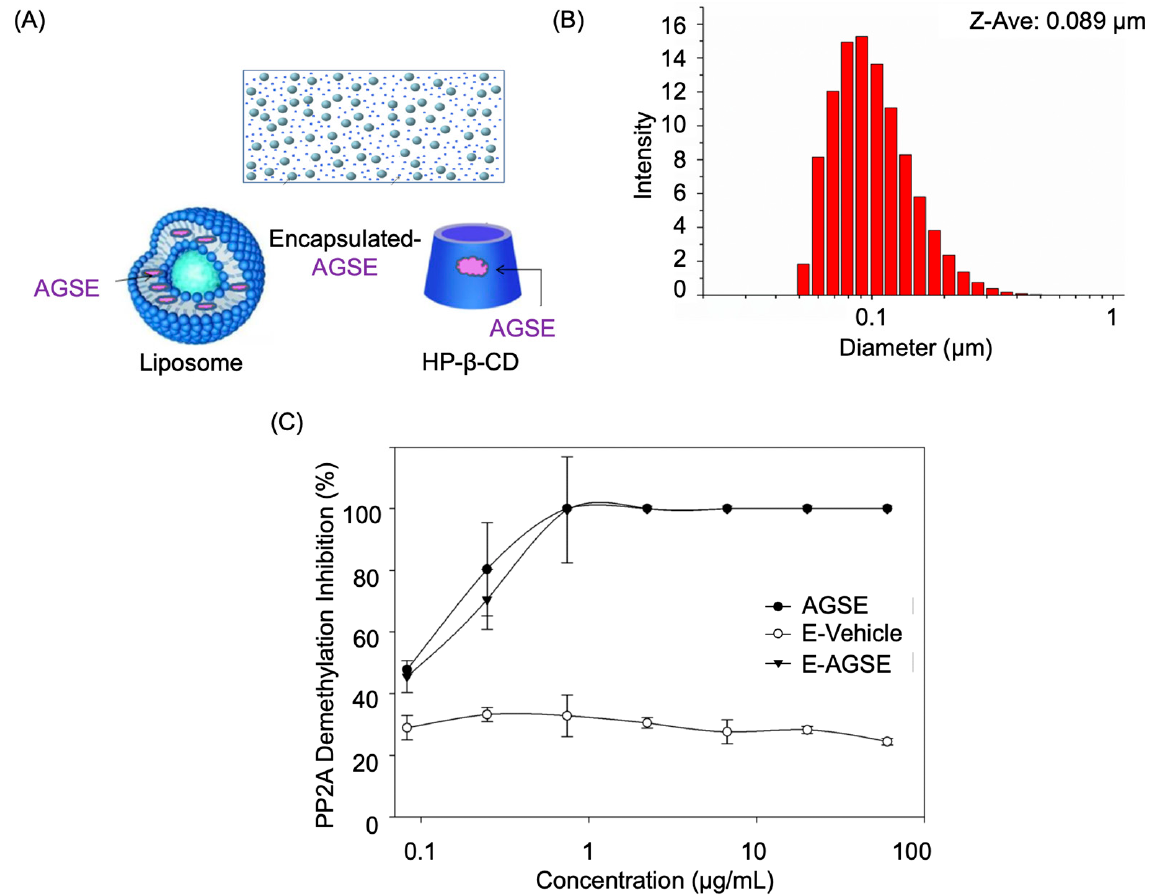
Figure 1. Chemical encapsulation of AGSE retains inhibition of PP2A demethylation activity. ( A ) Chemical encapsulation formulation utilizing liposome and HPCD-based approaches. ( B ) The particle size of the E-AGSE nanocarriers was measured by DLS. ( C ) The PP2A-demethylating enzyme PME1 and 3H methyl-tagged PP2A were incubated with various concentrations of AGSE and E-AGSE. Dose-dependent inhibition was monitored by 3H retained on methylated PP2A. The data represent the cumulative average ± SD of three independent experiments.